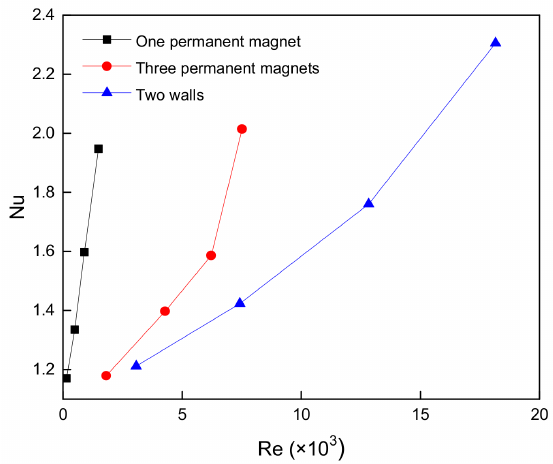
Figure 13. Nusselt number variations for Reynolds number at three cases.